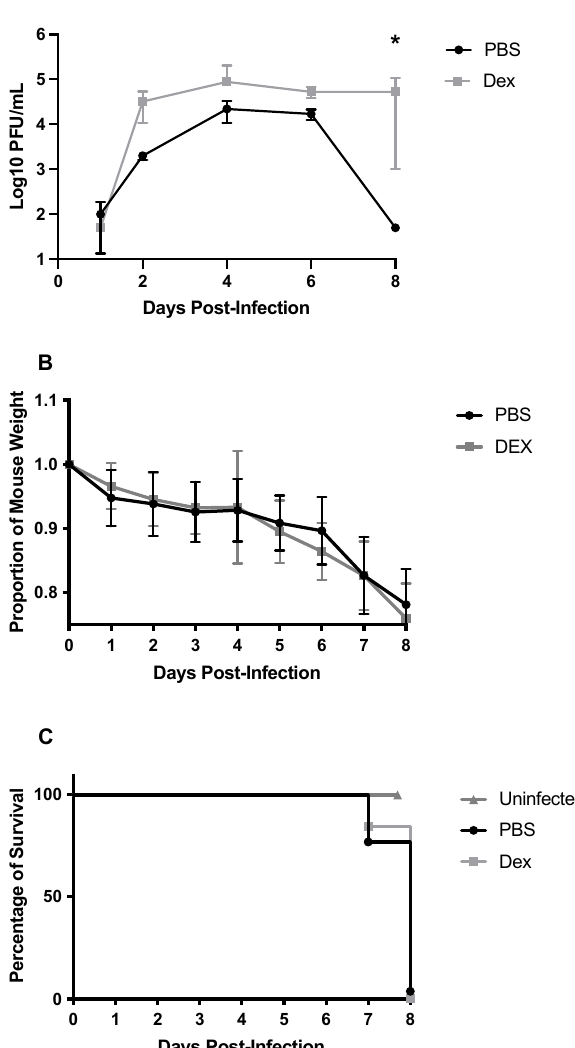
Figure 2. Viral lung titers ( A ), weight loss ( B ), and survival ( C ) of B/Florida/04/2006-challenged B6 mice. B6 mice were i.n. challenged with 10 3 PFU B/Florida/04/2006. Viral lung titers were determined on days 1, 2, 4, 6, or 8 pi by virus plaque assay. Dots represent the mean PFU/mL of lung homogenate +/ − SEM. The limit of detection for viral plaque assay was 50 PFU/mL. Weight loss and survival were recorded daily for 8 days post-infection. Points represent mean +/ − SEM of the proportion of original weight. * p < 0.05 between the PBS and DEX-treated mice by Multiple Mann-Whitney U tests (n = 5 mice/group).